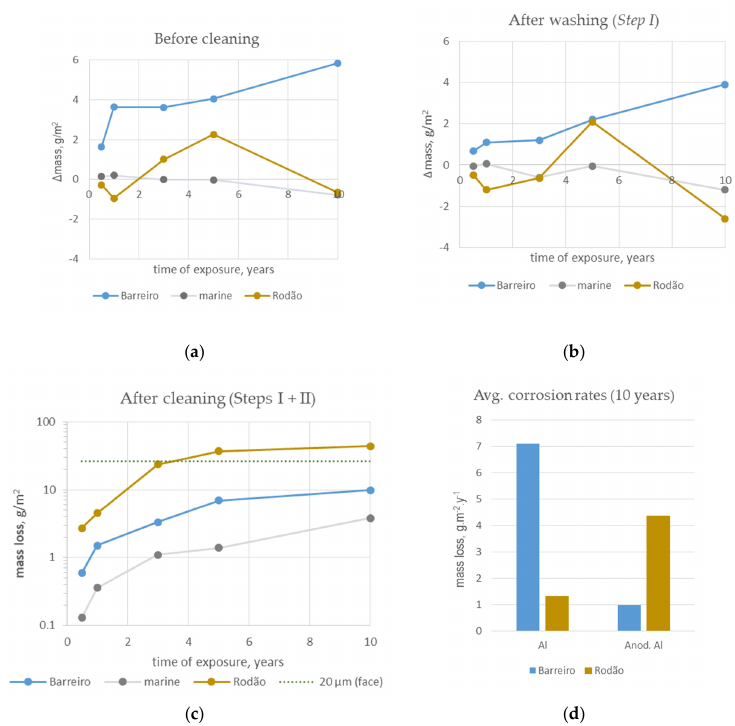
Figure 6. Mass variations with exposure: mass changes after ( a ) exposure, before cleaning and after ( b ) washing ( Step I cleaning procedure); ( c ) mass loss after washing and cleaning in nitric acid ( Steps I + II cleaning procedure); ( d ) comparison of anodized aluminum and bare aluminum corrosion rates calculated based on the mass losses obtained after ten years of